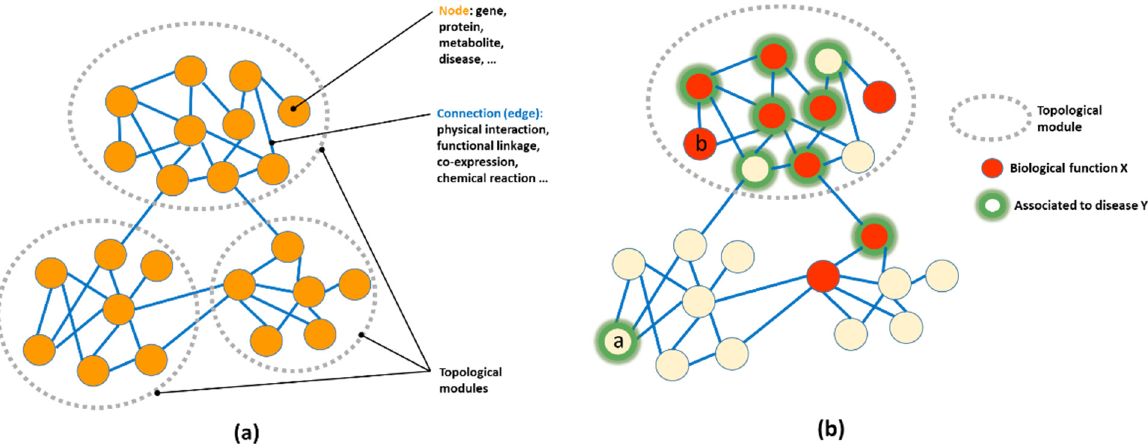
Figure 1. ( a ) Schematic representation of a generic biological network coding linkages between different molecular entities. This schematic network has three topological modules (clusters). Real biological networks can have tens of thousands of nodes and hundreds of thousands of relationships. ( b ) Relationships between topological, functional, and disease-related modules. The proteins involved in a specific function (“X”) are coloured red. Those associated with a given disease (e.g., those whose mutation is known to cause “disease Y”) are highlighted with green halos. Proteins known to be involved in “X” tend to cluster in the network. Those associated with disease “Y” tend to cluster in the same topological module, indicating that disease “Y” may be related to a malfunction of the biological process “X”. Alterations of other proteins in the same topological/functional module may also lead to the same disease as they disrupt the same process, even if they have not been detected yet (e.g., gene “b”). Conversely, genes far apart from the cluster might be discarded (e.g., “a”). Network propagation methods would tend to expand that initial set of Y-associated genes to the whole topological cluster as well as discard nonrelated genes.